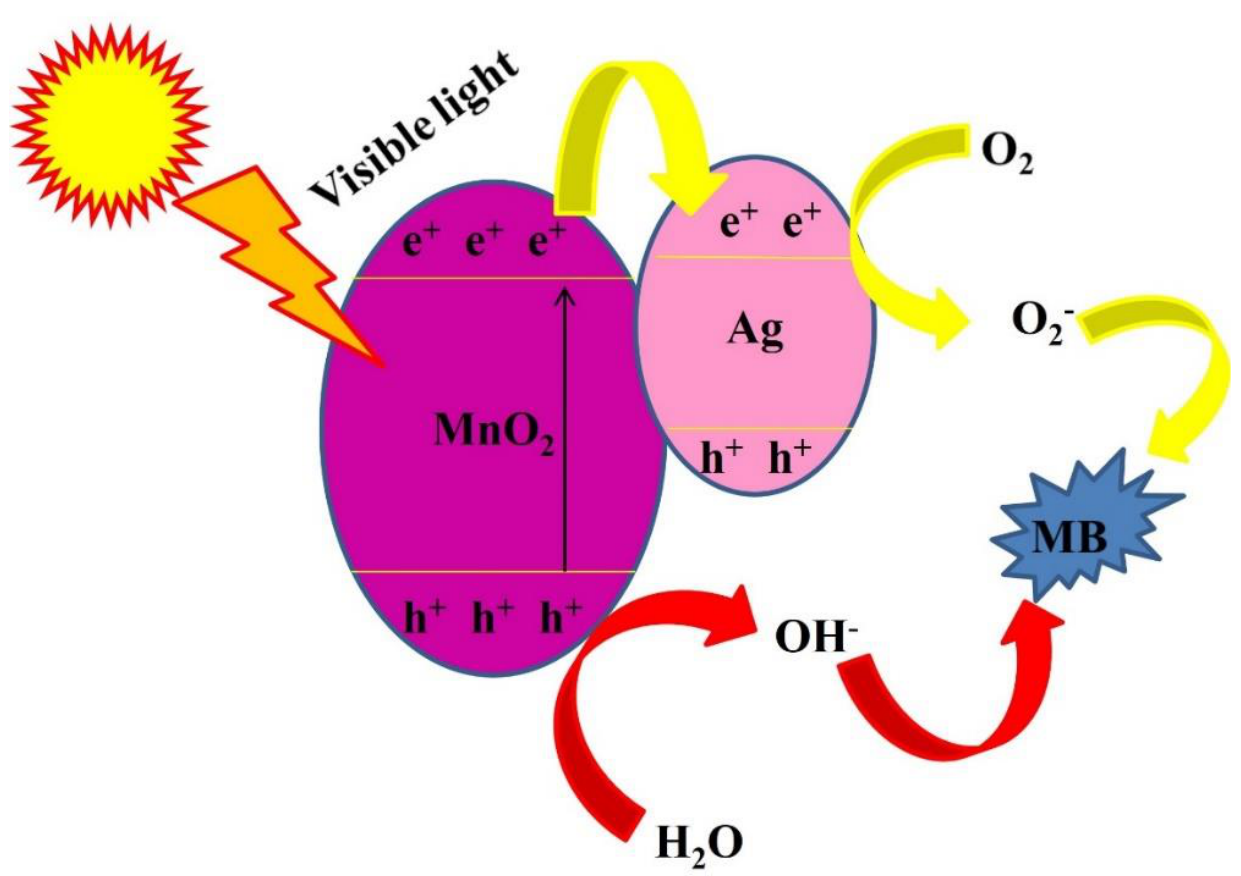
Figure 9. A proposed mechanism for photocatalytic reaction with MnO 2 doped with Ag nanoparti- cles.